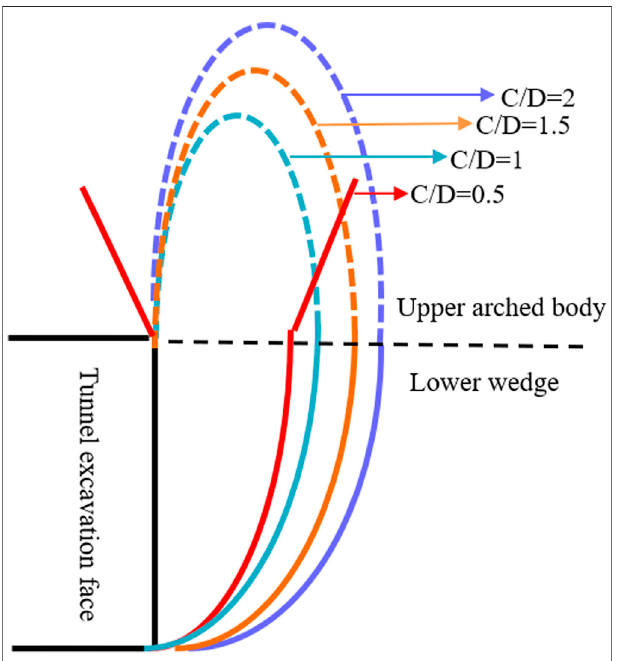
FIGURE 10 | Relationship between C / D and tunnel instability mode.